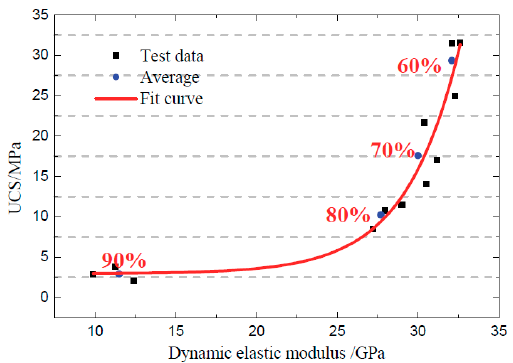
Figure 11. Relationship between the dynamic elastic modulus and UCS.